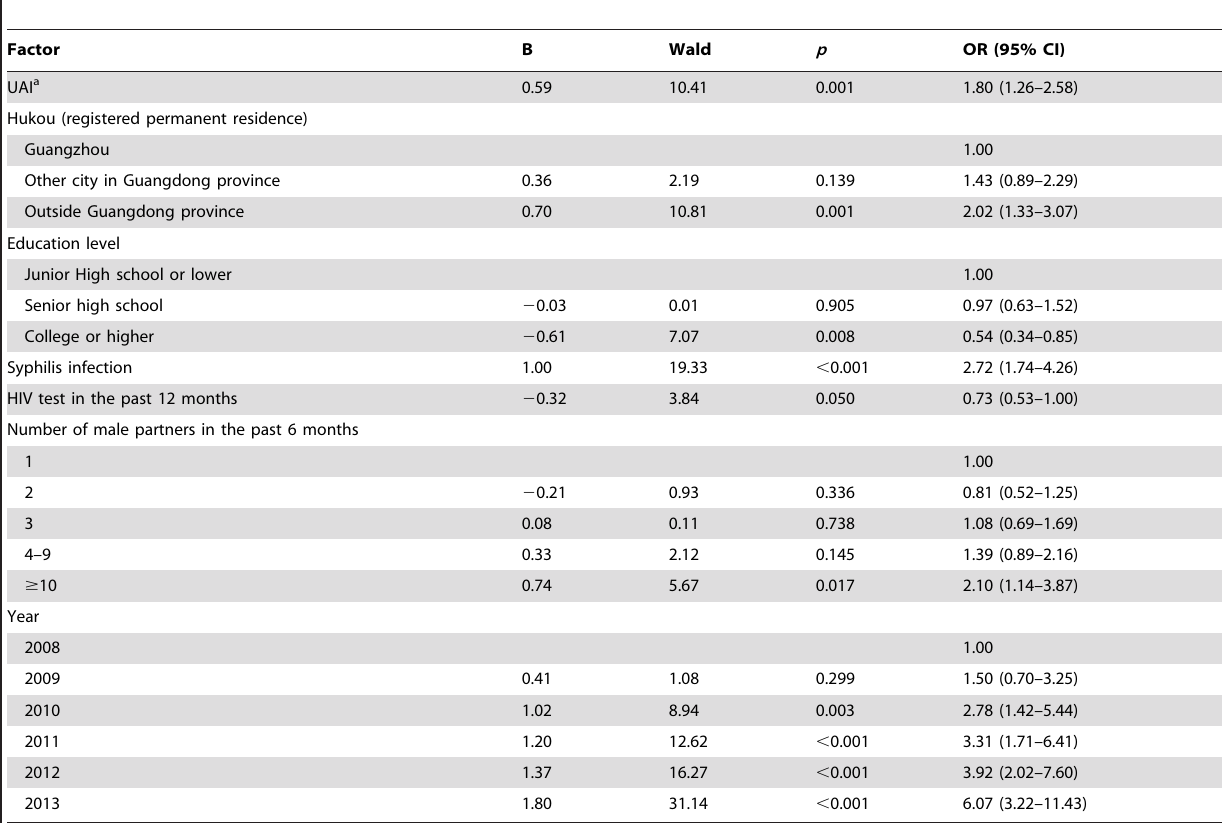
Table 3. Factors associated with HIV infection among MSM in Guangzhou, 2008–2013, by Logistic regression